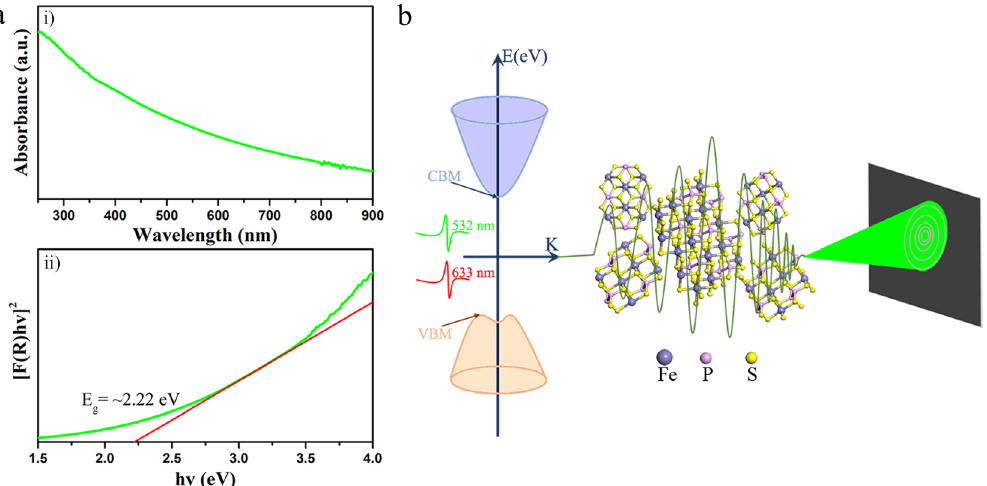
Figure 4: (a) (i) UV – vis – NIR diffusive reflectance absorption spectra and (ii) the curve for the transformed Kubelka – Munk function with the photon energy for the FePS 3 nanosheets collected at 5000 rpm. The FePS 3 nanosheets are an indirect semiconductor with a corresponding bandgapof ∼ 2.22eV.(b)ThemechanismfortheinteractionsbetweenthelightandtheFePS 3 nanosheetswiththeoptical-bandgapstructurein which the location of the conduction band minimum (CBM) is at the K point and the corresponding valence band maximum (VBM) is along the K → Γ path, showing the excitation spectrum of the free carriers of FePS 3